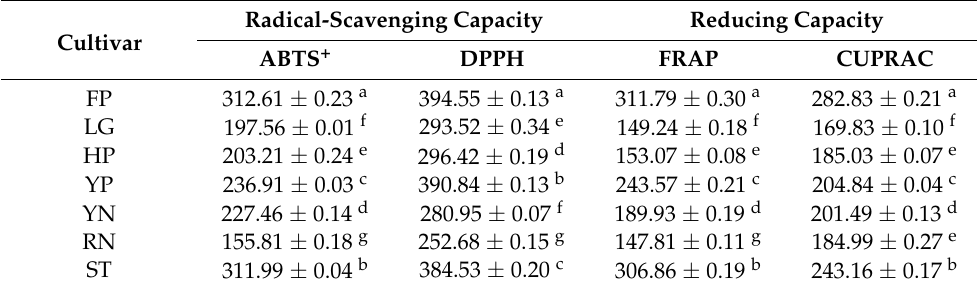
Table 6. Antioxidant capacities ( µ mol TEs/100 g) of the seven peach